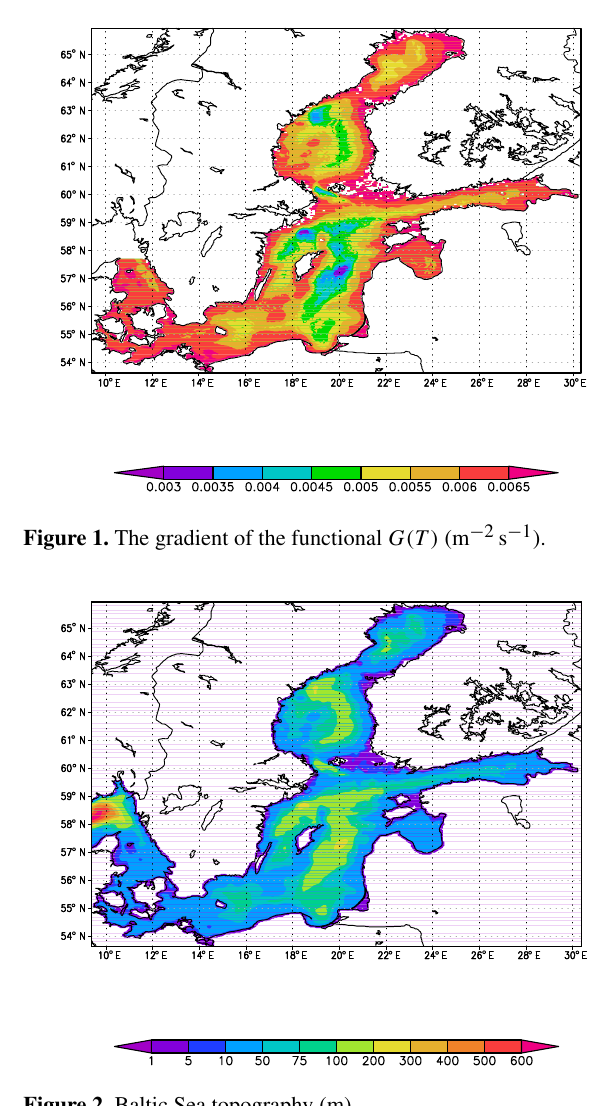
Figure 2. Baltic Sea topography